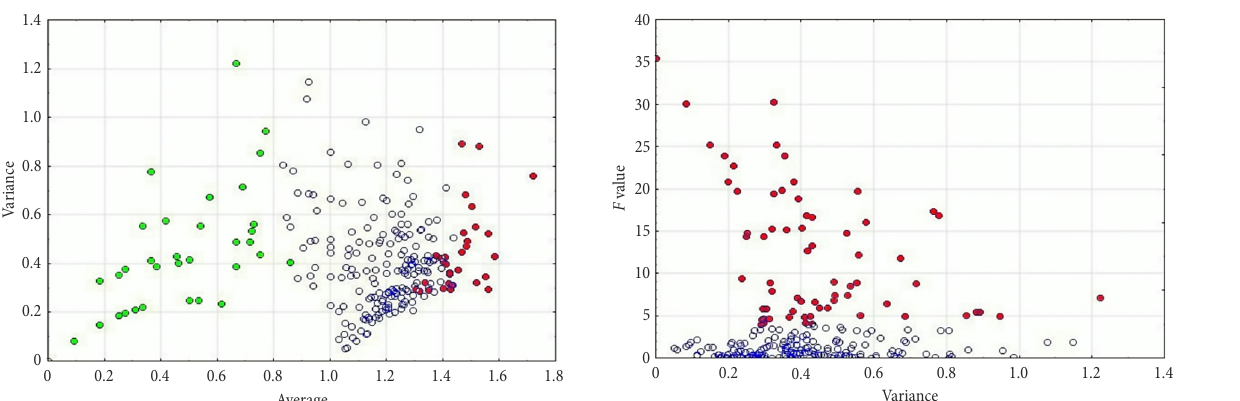
Fig. 3. Display of ε and v values of subsections that are significantly different